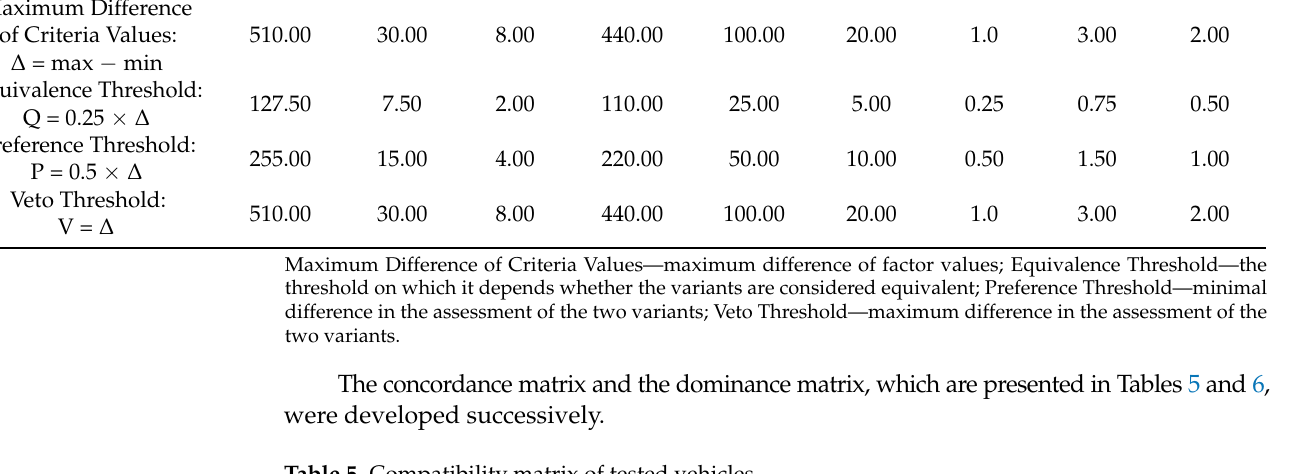
Table 5. Compatibility matrix of tested vehicles.